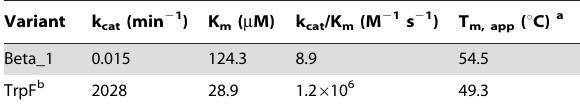
Table 3. Biochemical characterization of a chimeric variant.